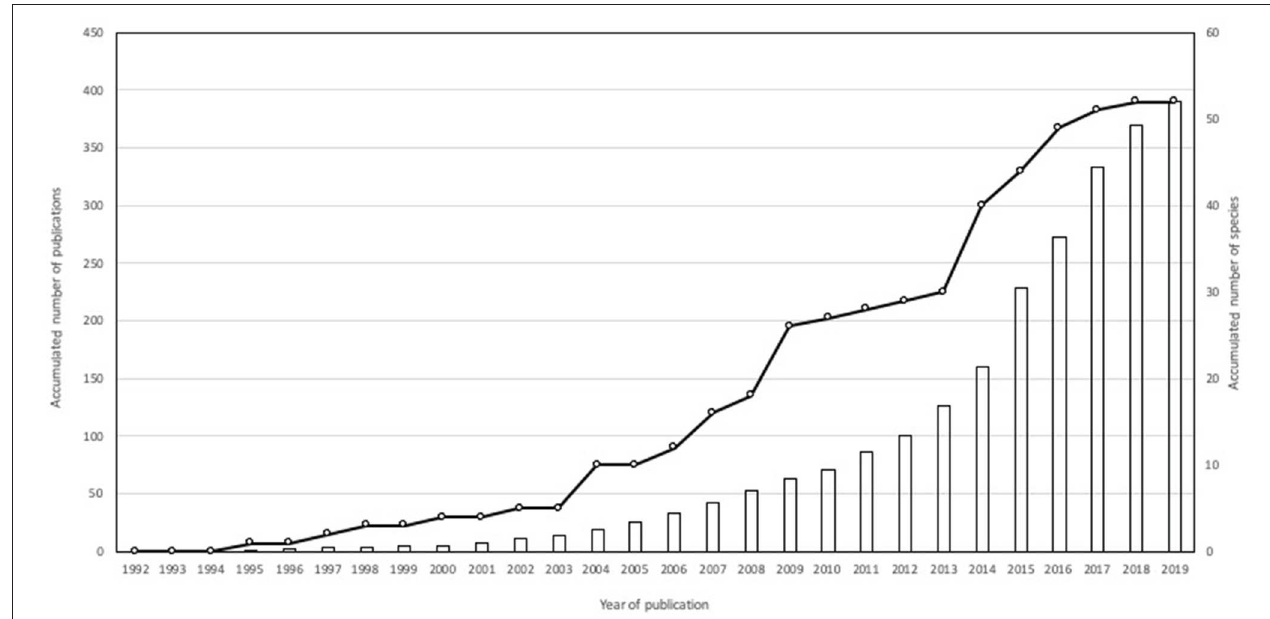
FIGURE 1 | Accumulated number of publications (bar) and carnivores reported (circle) in the reviewed sample between 1992 and 2019 ( N = 391).